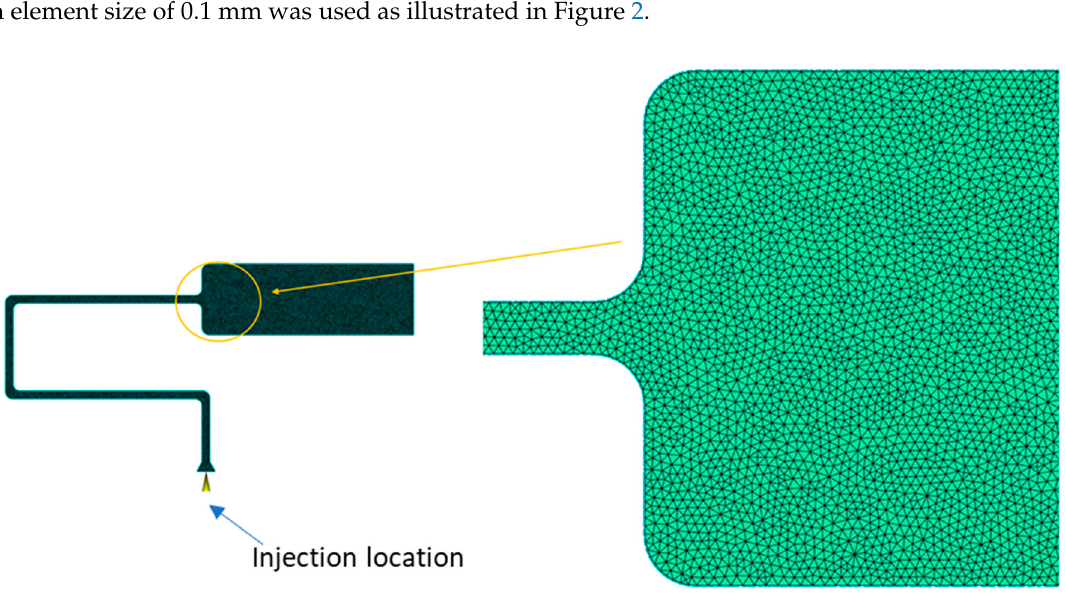
Table 2. Material properties of Polypropylene (PP) and Acrylonitrile butadiene styrene (ABS) .